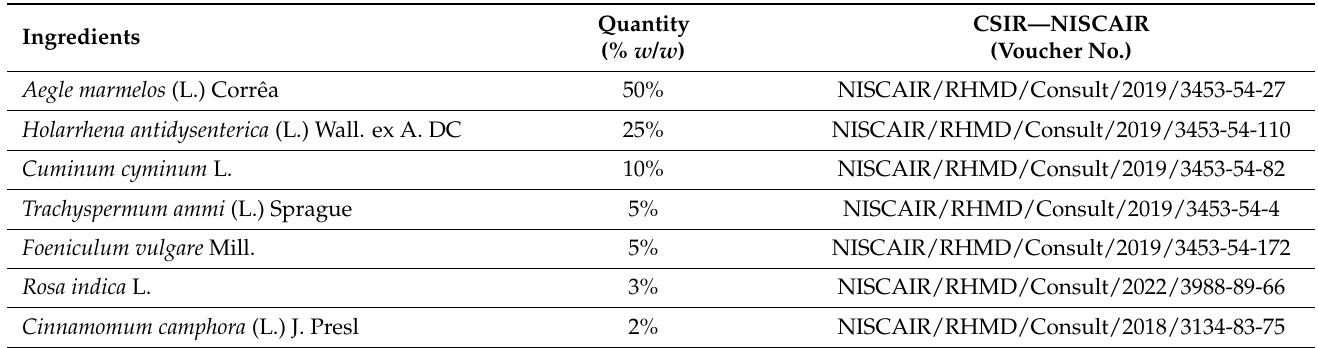
Table 1. Percentage of herbal extracts used in Cologrit formulation